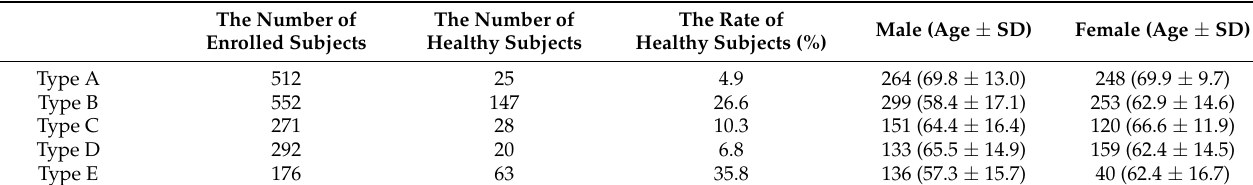
Table 2. Number and rate of healthy subjects in each PAM-identified type.